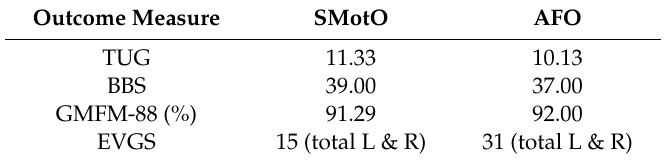
Table 5. Participant 4 outcome measure comparative results between SMotO and AFO.